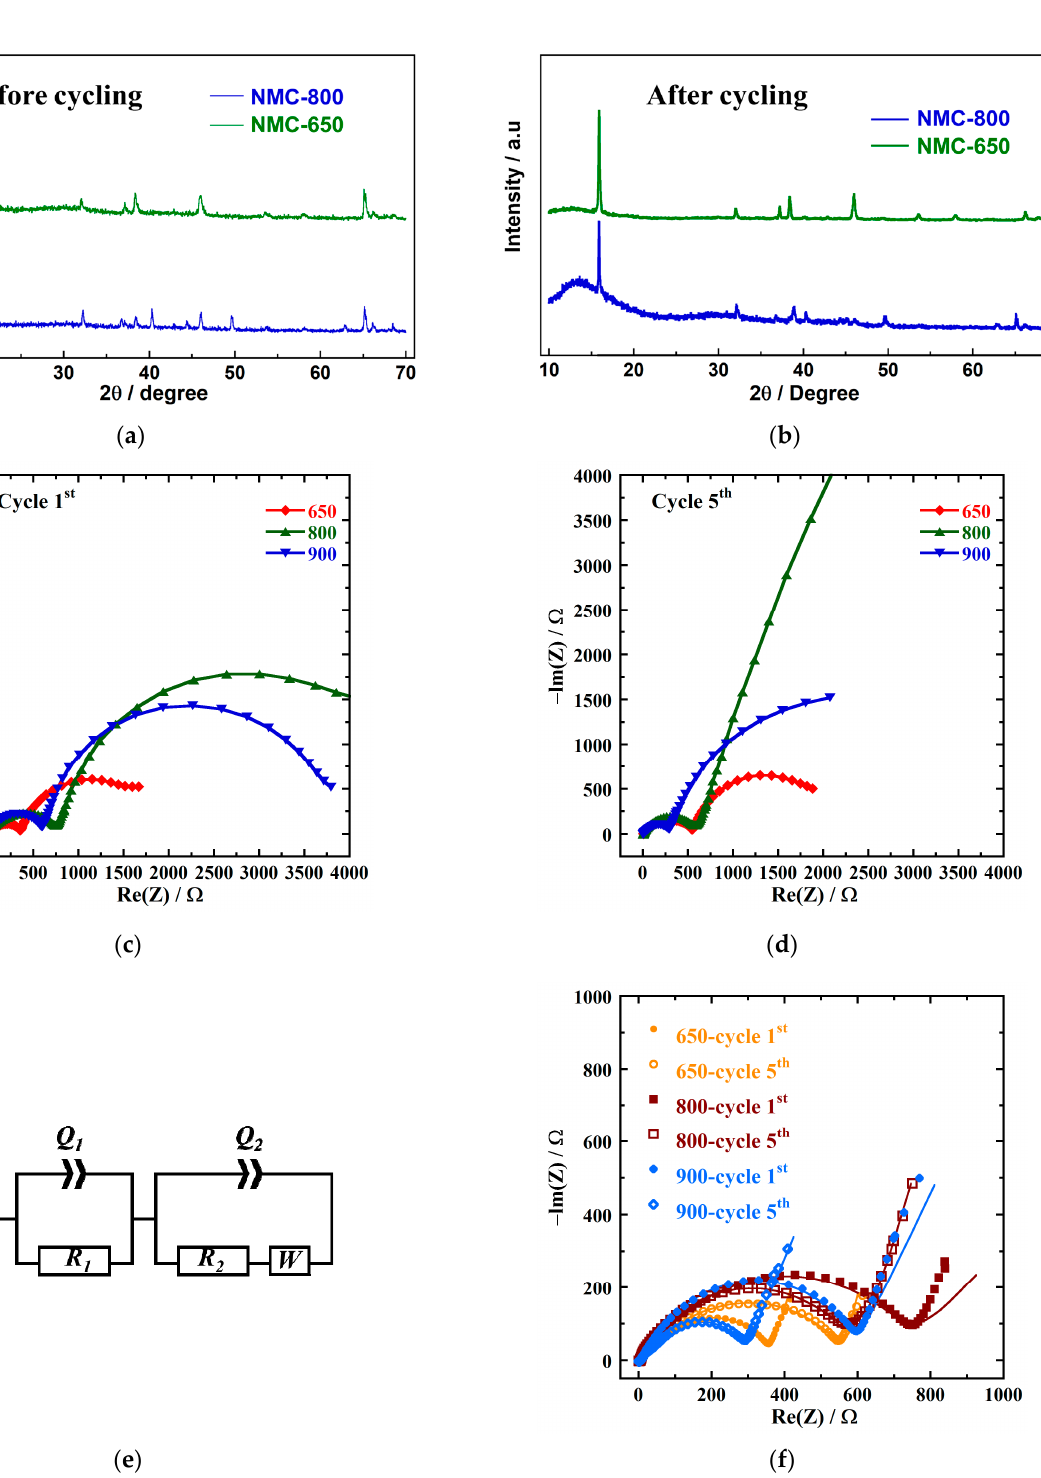
Figure 6. XRD patterns of the electrodes obtained ( a ) before and ( b ) after cycling. EIS spectra of the electrode NMC-650, NMC-800 and NMC-900 obtained at ( c ) the first and ( d ) the fifth cycles. ( e ) Equivalent circuit that use to fit the EIS results and ( f ) Nyquist plot for the electrodes with a frequency range from 10 6 to 0.1 Hz. The measurement data are shown by the dots and the fitting curves are presented by the solid